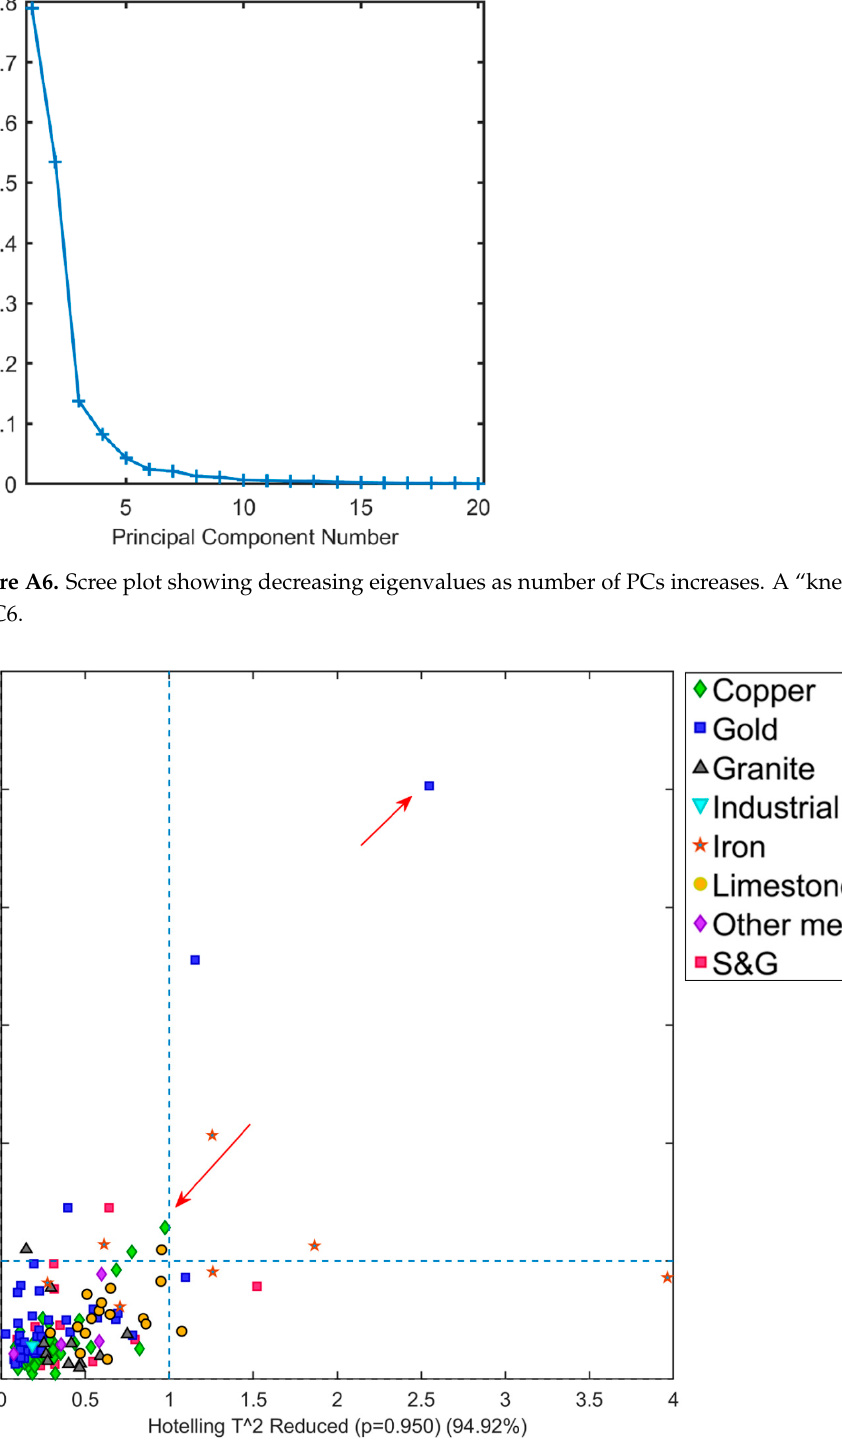
Figure A7. Hotelling T 2 v. Qresidual values from PCA model for FTIR spectra.